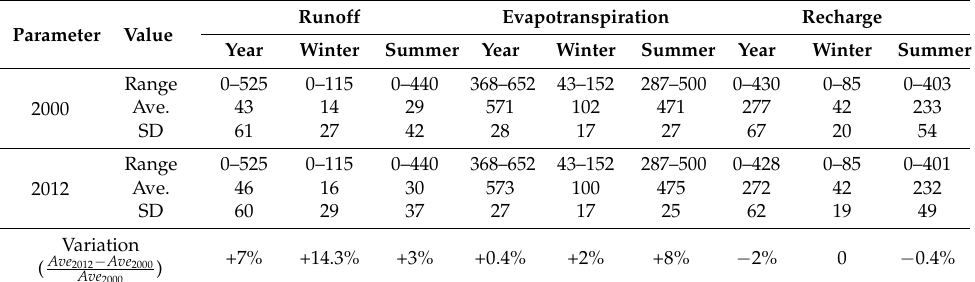
Table 4. Seasonal and annual water balance components in the whole Beijing area from 2000 to 2012 (mm).